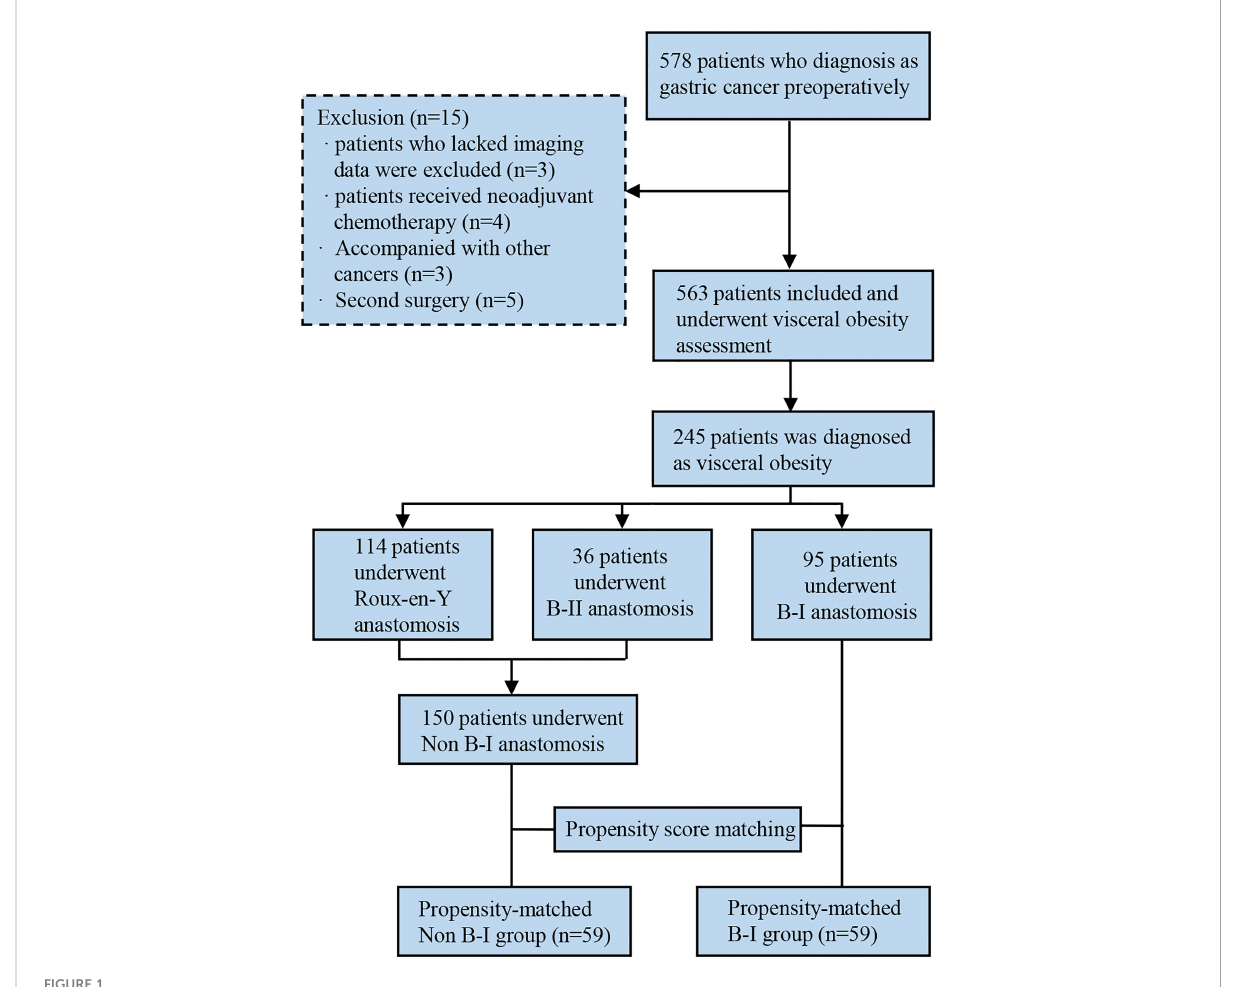
FIGURE 1 Flow diagram of the study